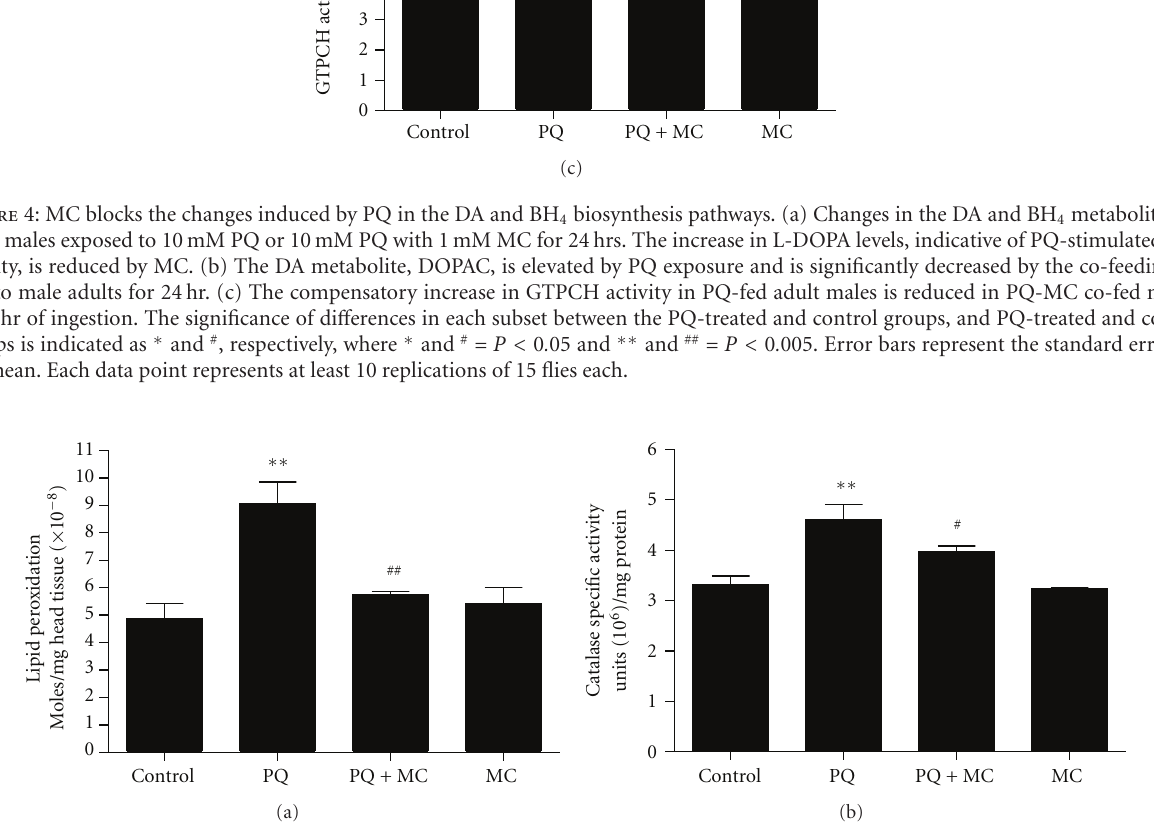
Figure 5: MC reduces PQ-generated reactive oxygen species. (a) The level of lipid peroxidation product was determined in head extracts of males that had ingested PQ or PQ with MC for 24hr. MC significantly decreases the amount of lipid peroxidation induced by PQ. (b) MC reduces the specific activity of catalase after 24hr of ingestion in co-fed male flies. The significance of di ff erences between the PQ-treated and control groups and between the PQ-treated and co-fed groups was indicated as ∗ and # , respectively, where ∗ and # = P < 0 . 05. Error bars represent standard error of the mean. The experiments were done as 5–8 replicas of 10 head